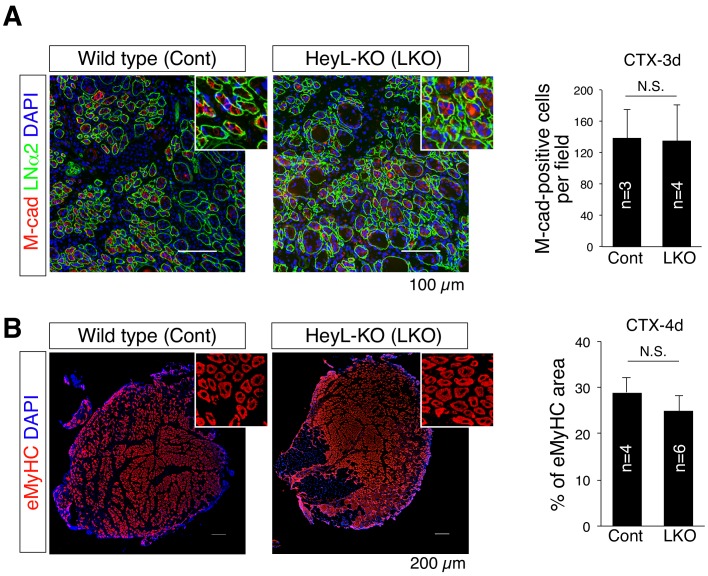
Normal muscle-regenerative ability in HeyL-KO mice.(A) Immunostaining of M-cadherin (M-cad; red) and laminin α2 (LNα2; green) in sections of regenerating tibialis anterior muscle at 3 days after CTX injection (CTX-3d). Scale bar: 100 μm. Bar graph shows the frequency of M-cadherin+ cells per field in wild-type (Cont; n = 3) and HeyL-KO (LKO; n = 4) mice. N.S.: not significant. (B) Immunostaining of embryonic myosin heavy chain (eMyHC; red) in sections of regenerating tibialis anterior muscle at 4 days after CTX injection (CTX-4d). Scale bar: 200 μm. Bar graph shows percentages of eMyHC+ area in wild-type (Cont; n = 4) and LKO (n = 6) mice. N.S.: not significant. Data represent the mean ± standard deviation. A two-sided Student’s t test was performed.10.7554/eLife.48284.013Figure 4—figure supplement 2—source data 1.Numerical data for making the graphs in Figure 4—figure supplement 2.